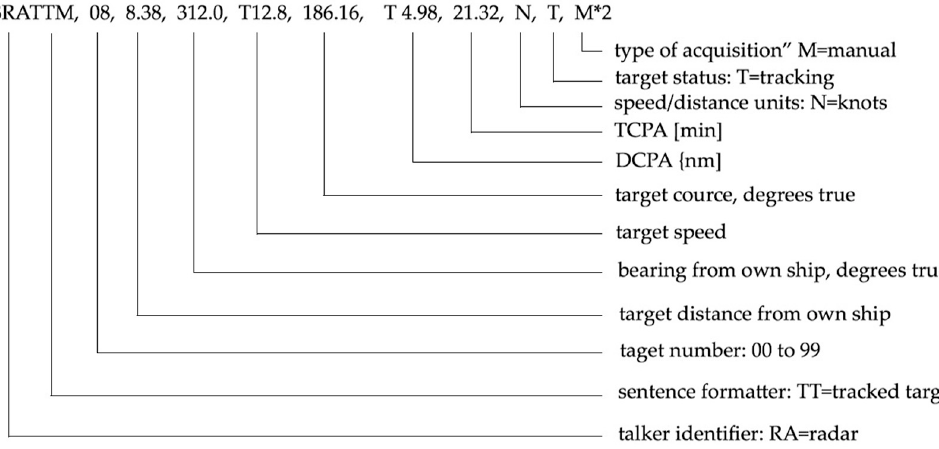
Figure 5. The format of the data frame containing the sample information about the tracked ship.